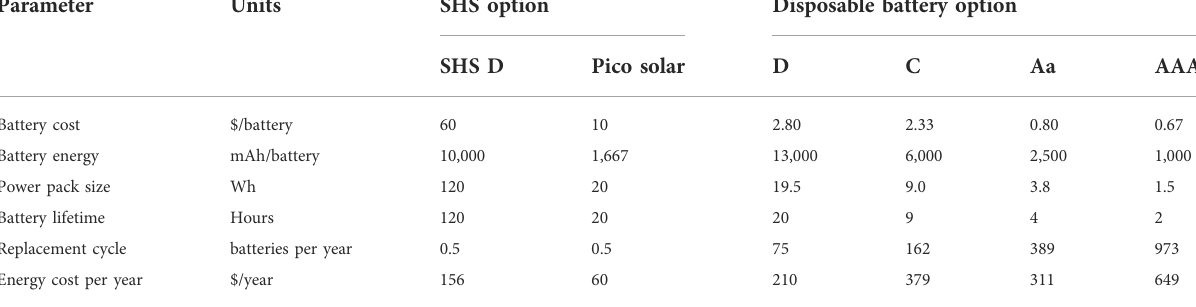
TABLE 3 Cost analysis with different battery con fi gurations (4 × LED at 1.25 W